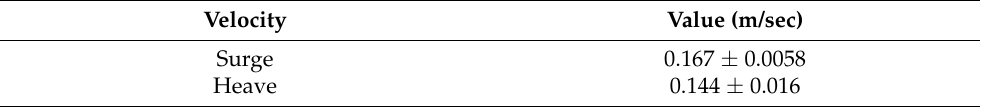
Table 3. Measured Table 3. Measured velocities .